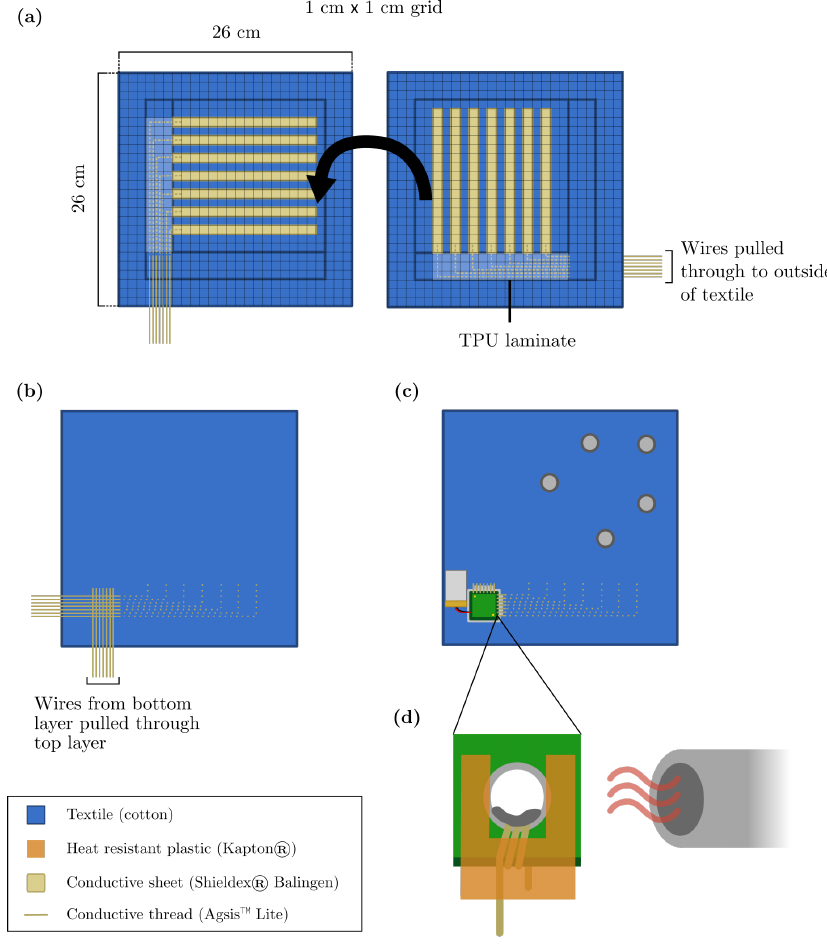
Figure 2. Manufacturing process of the smart textile. ( a ) Dimensions of the bottom (left) and top (right) layer of the textile pouch. The conductive strips are laminated onto the textile using 35µm thick TPU. Conductive thread is sown onto the strips and routed to a corner of the textile. The black arrow indicates how the top layer should be turned over onto the bottom layer. ( b ) The conductive threads from the bottom layer are pulled through the top layer and both layers are merged by laminating. ( c ) The PCB holder is sewn/glued to the textile and the PCB is attached. The threads are connected to the PCB as detailed in ( d ). Push buttons are sewn into the textile. ( d ) The threads are connected